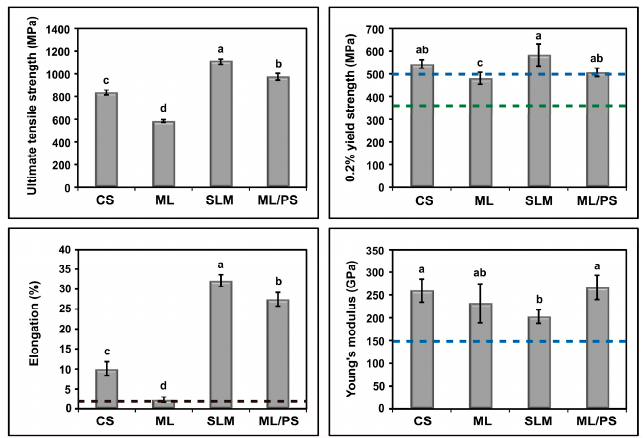
Figure 7. Comparison of mechanical properties of the four Co-Cr alloys tested ( n = 6). For each figure, means with different letters indicate statistical differences between groups ( p < 0.05). The green and blue horizontal lines indicate the type 4 and 5 criteria (minimum value), respectively, in ISO 22674. The type 4 and 5 criteria are the same for percent elongation (black horizontal line).